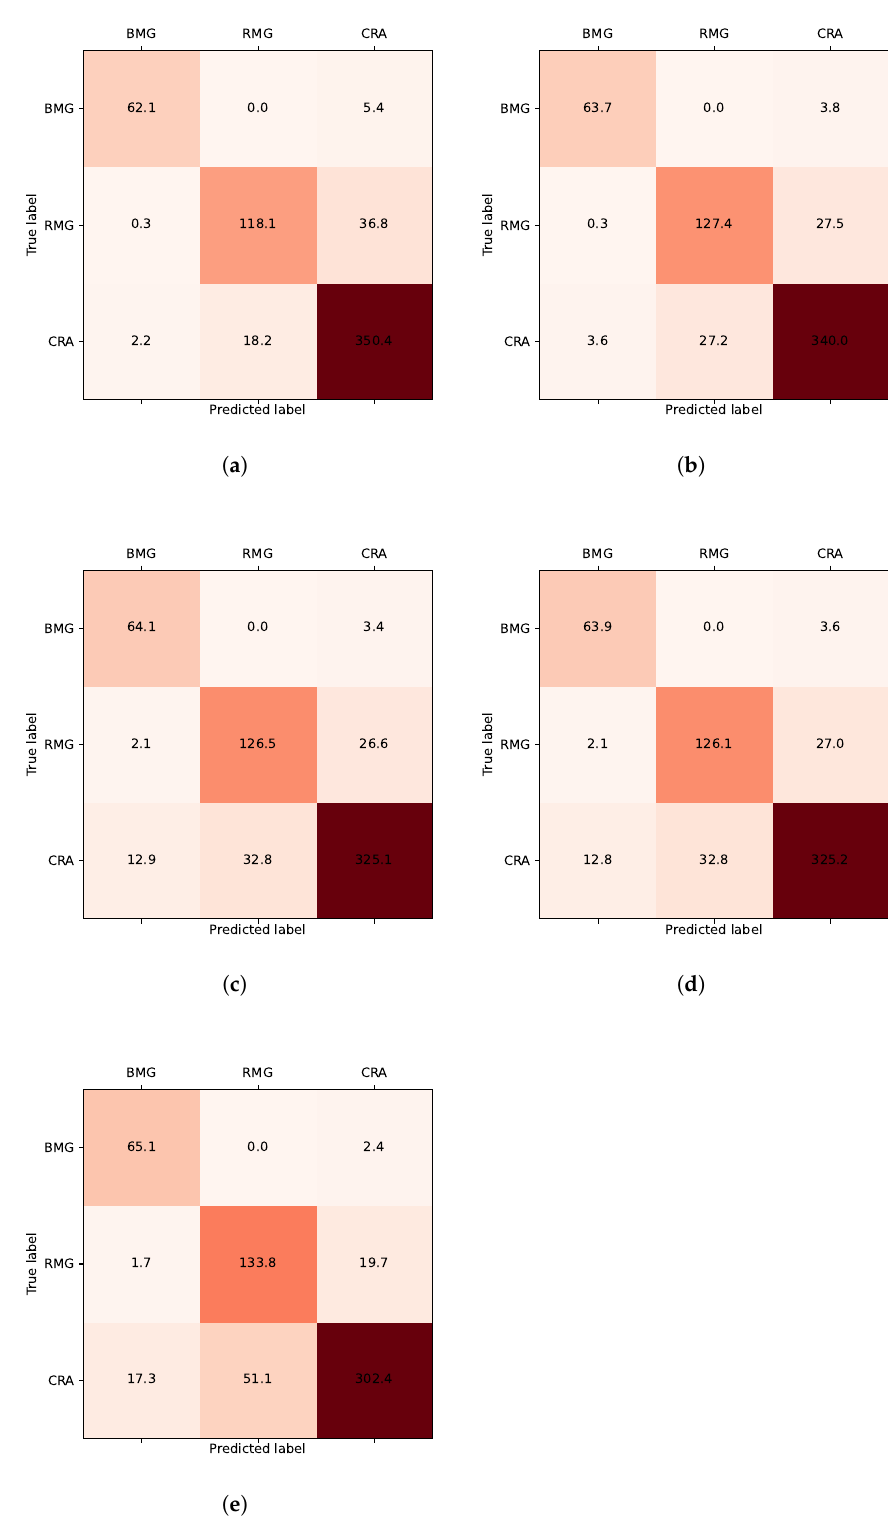
Figure 8. Averaging confusion matrices of ( a ) RF; ( b ) DBRF; ( c ) SMOTE + RF; ( d ) bSMOTE + RF; ( e ) ADASYN + RF. “BMG” is the minority